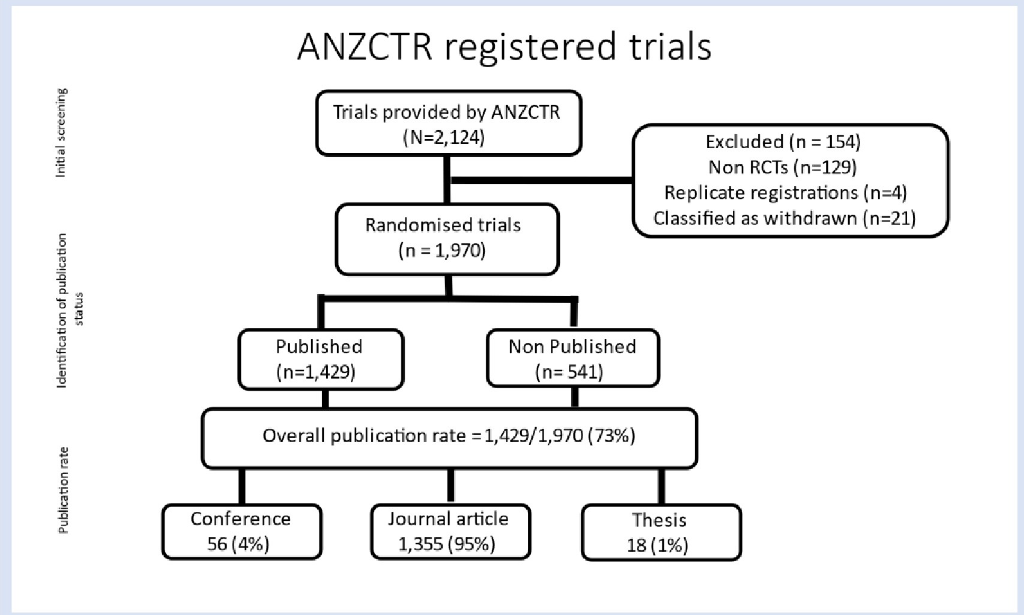
Fig 1. Flow diagram from screening ANZCTR registrations to verification of publication